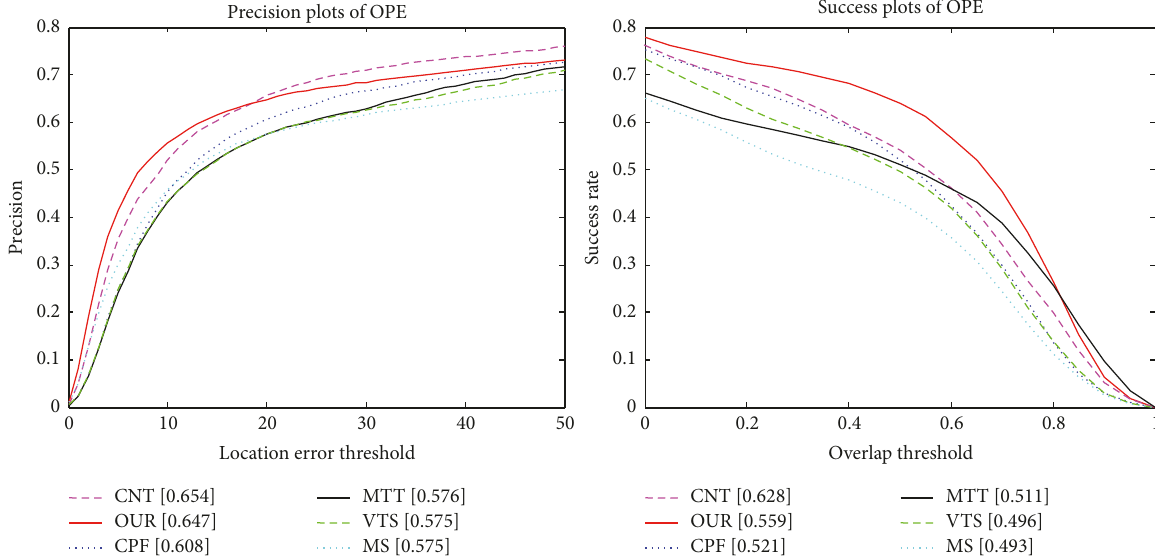
Figure 2: OPE of the success plots and precision plots in the top 6 trackers.